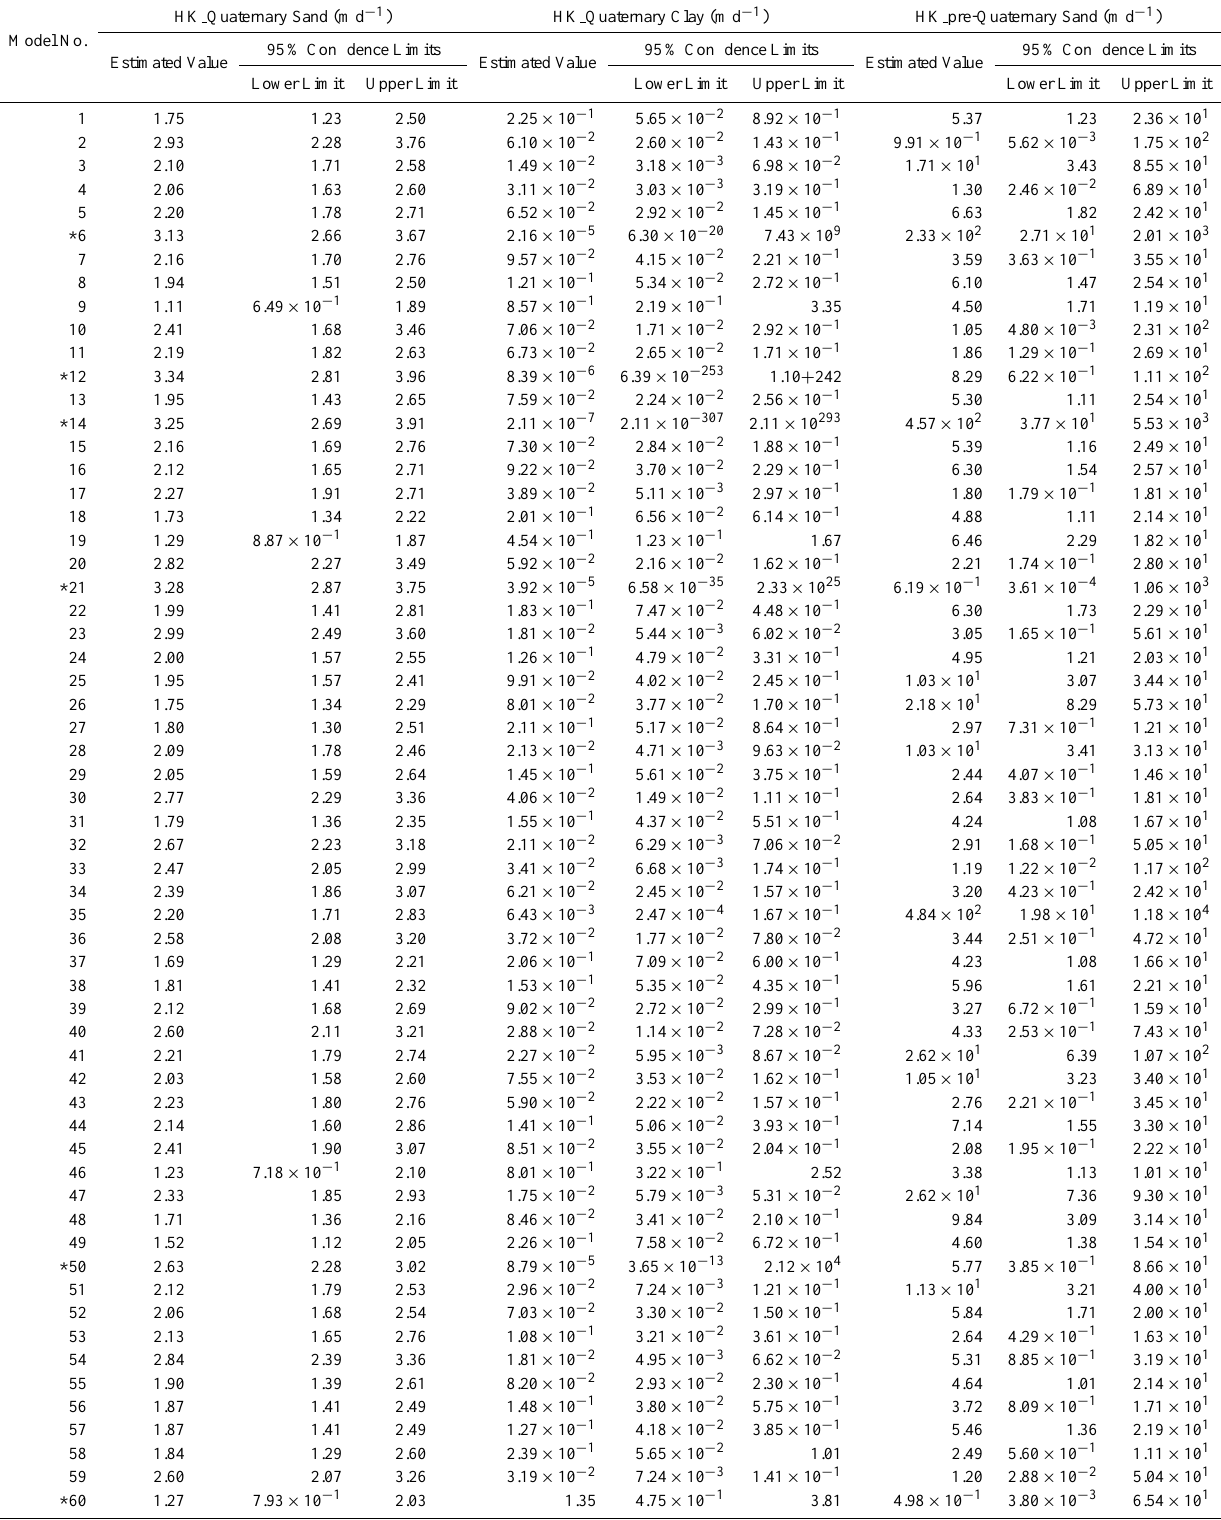
Table A1. Estimated hydraulic conductivity and confidence limits from PEST.